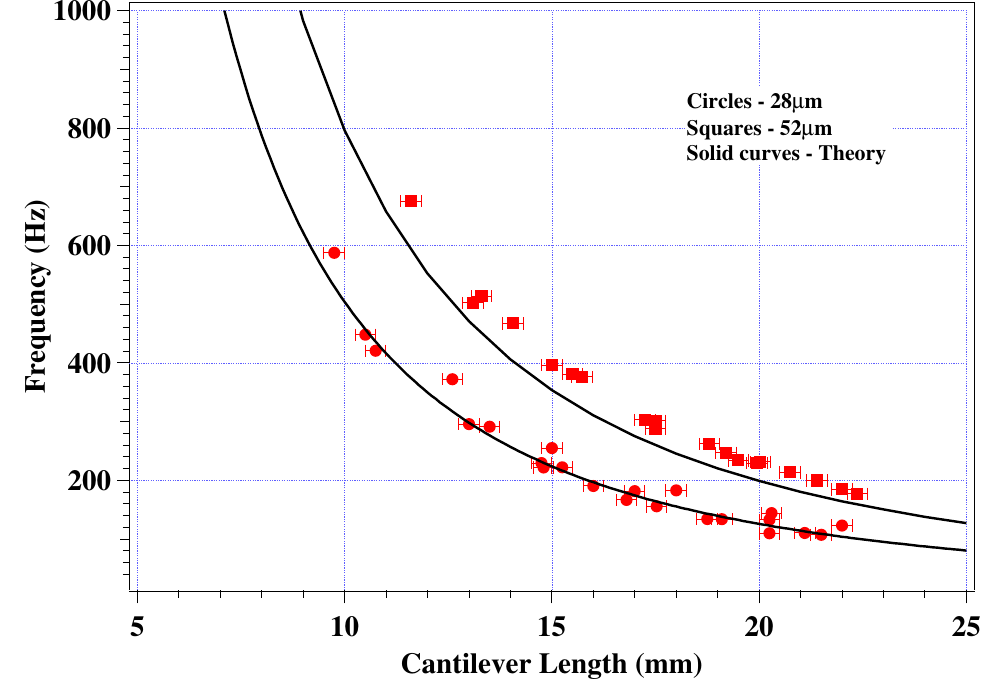
Figure 4 . The dependence of resonance frequency on the film thickness. The specific mode shown here is Mode